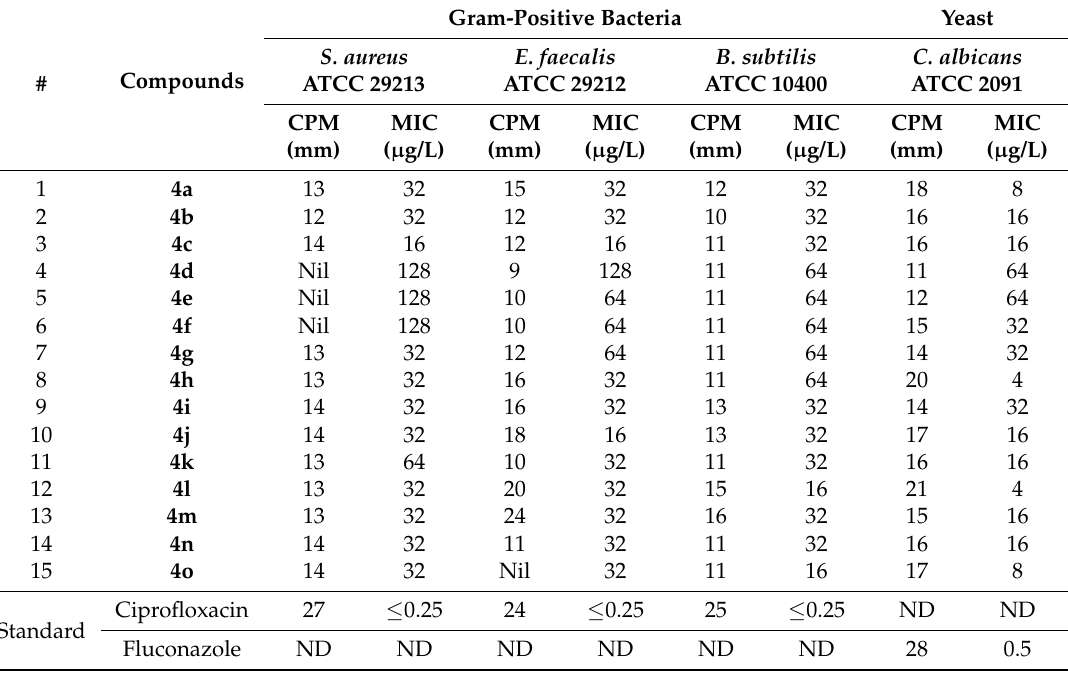
Table 2. Results of cup-plate method and minimal inhibitory concentrations of the compounds that show antimicrobial